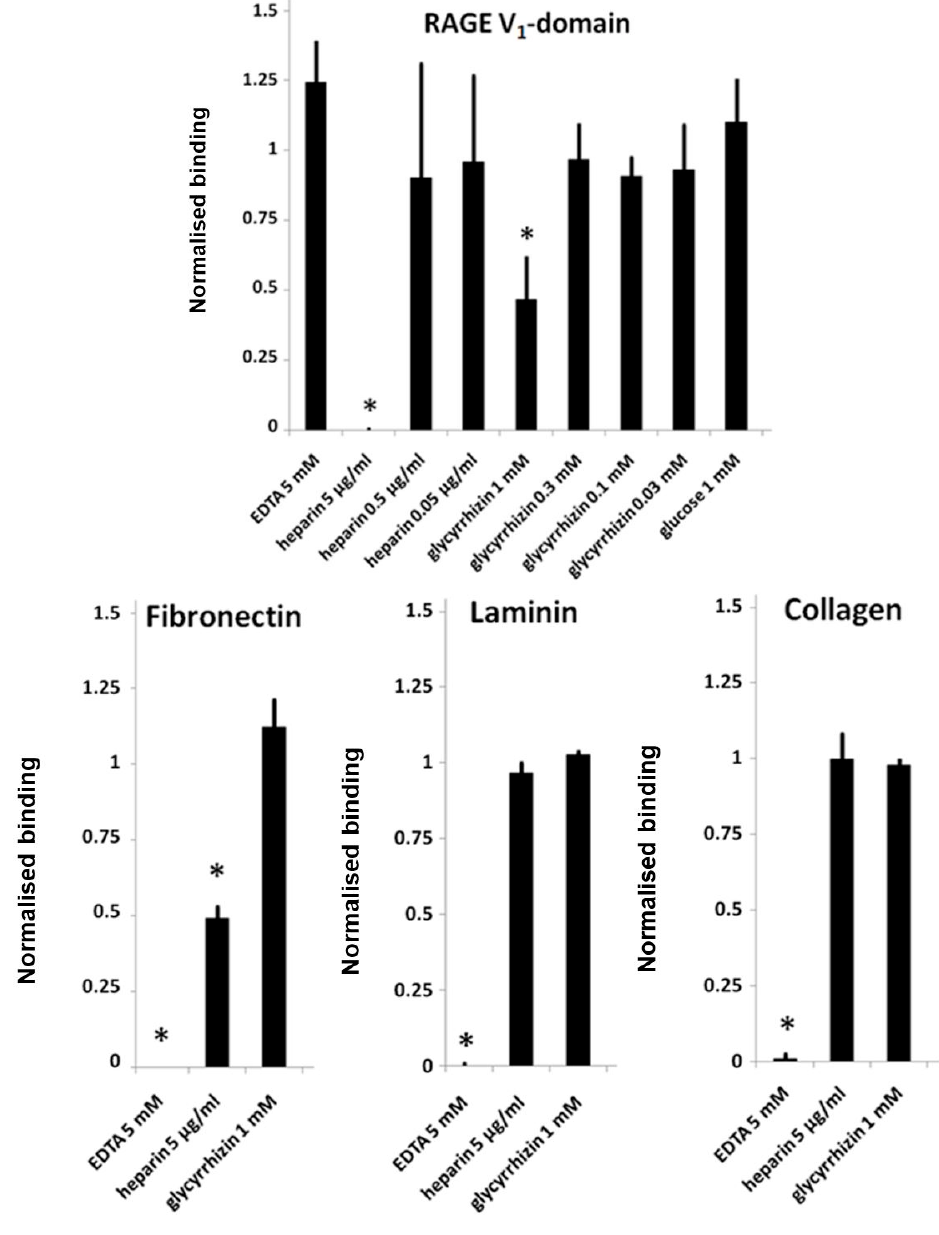
Figure 5. Glycyrrhizin and heparin inhibit cell surface AGE-mediated adhesion of PC3 prostate cancer cells to RAGE V 1 -domain. Microwells were coated with RAGE V 1 –Fc, type I collagen, laminin, or fibronectin (10 µ g/mL) and blocked with BSA. Cells with possible inhibitors in serum free media were added to wells and adhered for 30 min at 37 °C, and unbound cells were washed away. Adherent cells were quantitated with an intracellular acidic phosphatase assay. Uninhibited adhesion was defined as 1. N = 3–5; Error bars represent ±SD; * = p < 0.05 when compared with uninhibited control.